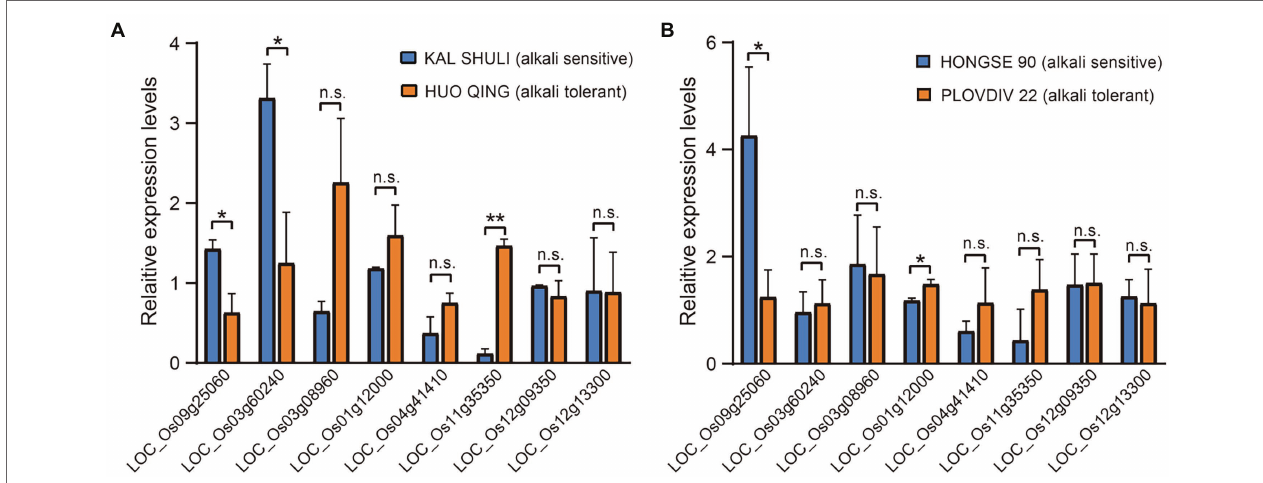
FIGURE 3 | Relative expression levels of candidate genes under alkali stress for 24 h. (A) In two representative Xian germplasms. (B) In two representative Geng accessions. Gene expression was normalized to that of the OsActin gene control. The relative expression levels were represented by fold change relative to the expression levels of the candidate genes. * p < 0.05 and ** p < 0.01 (two-tailed Student’ t -test). Data represent means ± SD ( n =